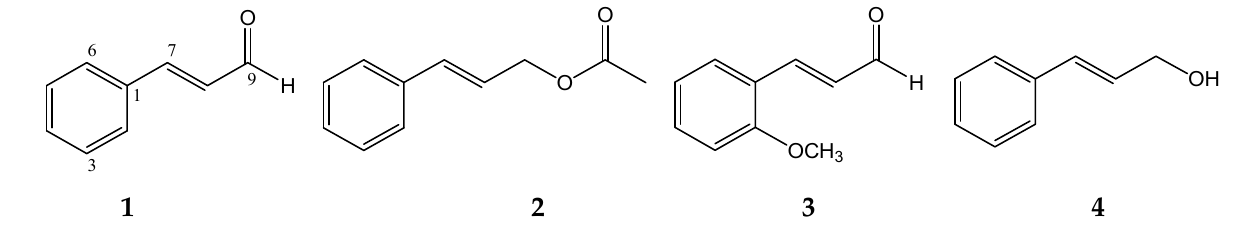
Figure 2. Chemical structure of cinnamon EOs components.